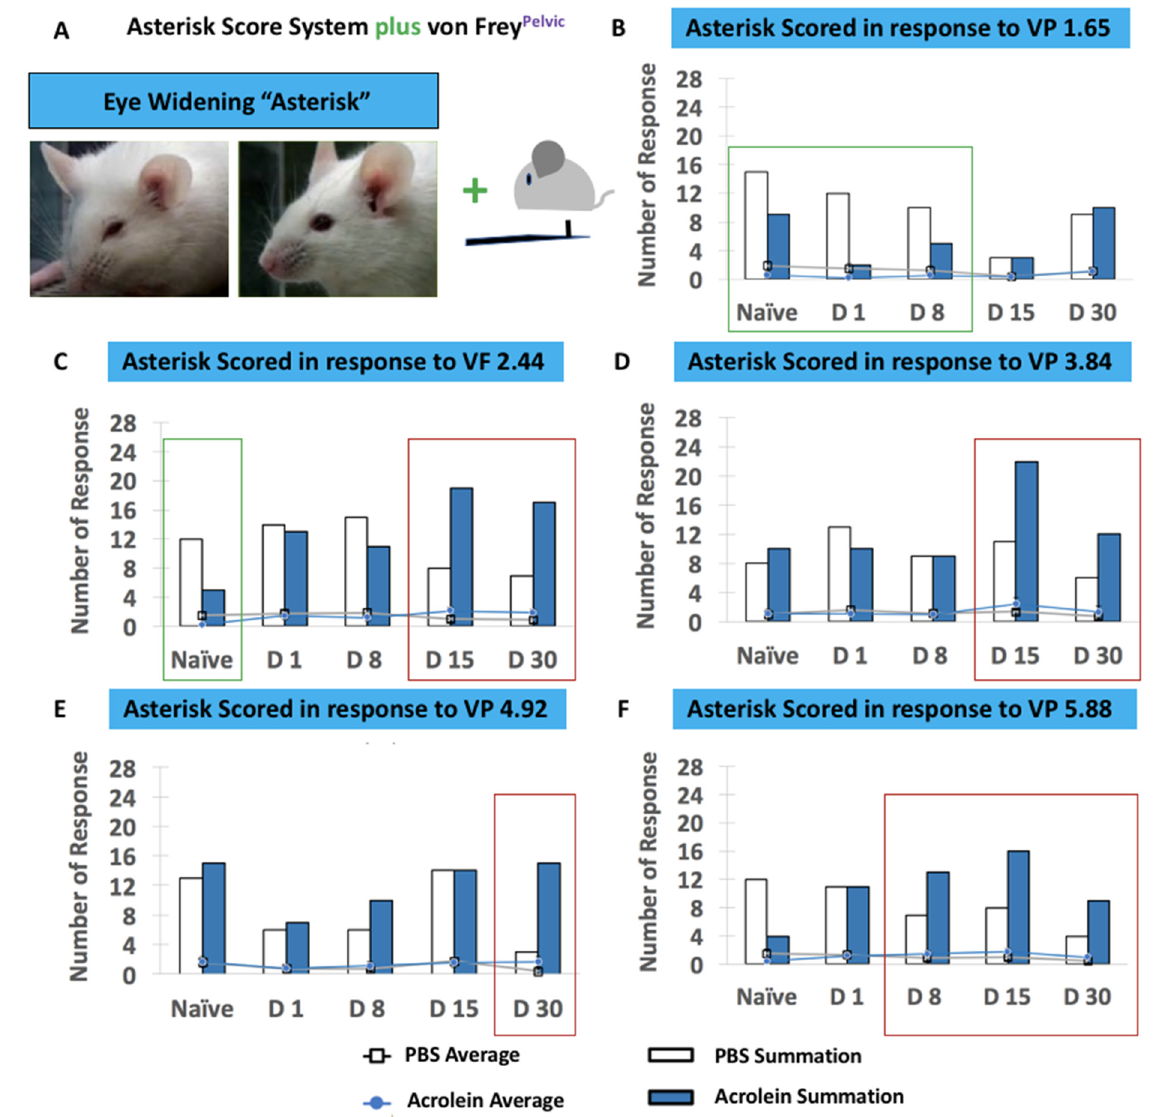
Figure 7. Concurrent assessment of the facial expression of pain and pelvic sensitivity shown in PBS vs. acrolein mice on the time points of naïve, days 1, 8, 15 and 30 pi as determined by the asterisk scoring system and von Frey application to the pelvic area. ( A ) Description of the asterisk scoring system with a combination of the application of von Frey filaments to pelvic area. The number of responses (bar graphs) and mice that scored an asterisk in response to the application of von Frey filaments 1.65 ( B ), 2.44 ( C ), 3.84 ( D ), 4.92 ( E ) and 5.88 ( F ).